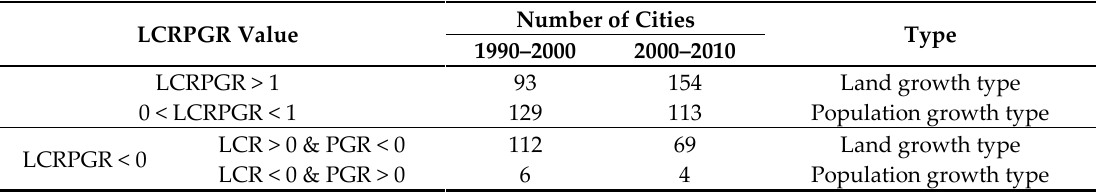
Figure 7. The LCRPGR valued in China in 1990–2010. ( a , b ) The spatial distribution at the 1 km × 1 km level. The data sources of uncertain type included an increase/decrease grid when calculating the LCR and PGR, which cannot calculate the LCRPGR value according to Formula (3). ( c , d ) The spatial distribution at the city level. The orange legend shows that the relationship between the LCR and PGR tends to be effective and shows coordinated development, while the blue legend indicates that the relationship tends to be ineffective and uncoordinated and should be considered. The darker the orange and blue legends are, the greater the population density of the city is. ( a , c ) The LCRPGR value in 1990–2000. ( b , d ) The LCRPGR values in 2000–2010. Table 4. The classification of the LCRPGR